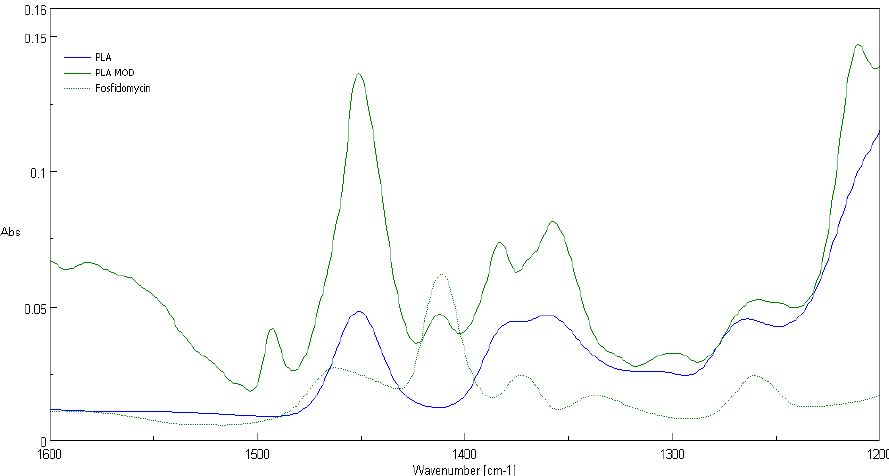
Figure 6. FTIR bands determined forfosfonomycin in wave number: 1410 cm −1 in spectra of the nonwoven sample coated by paste with Fosfomycin (PLA-MOD). Table 4. Characteristic FTIR bands determined for fosfomycin (Fosfm), polylactide (PLA) and the fosfomycin – polylactide nonwoven hybrid (PLA/Fosfm).